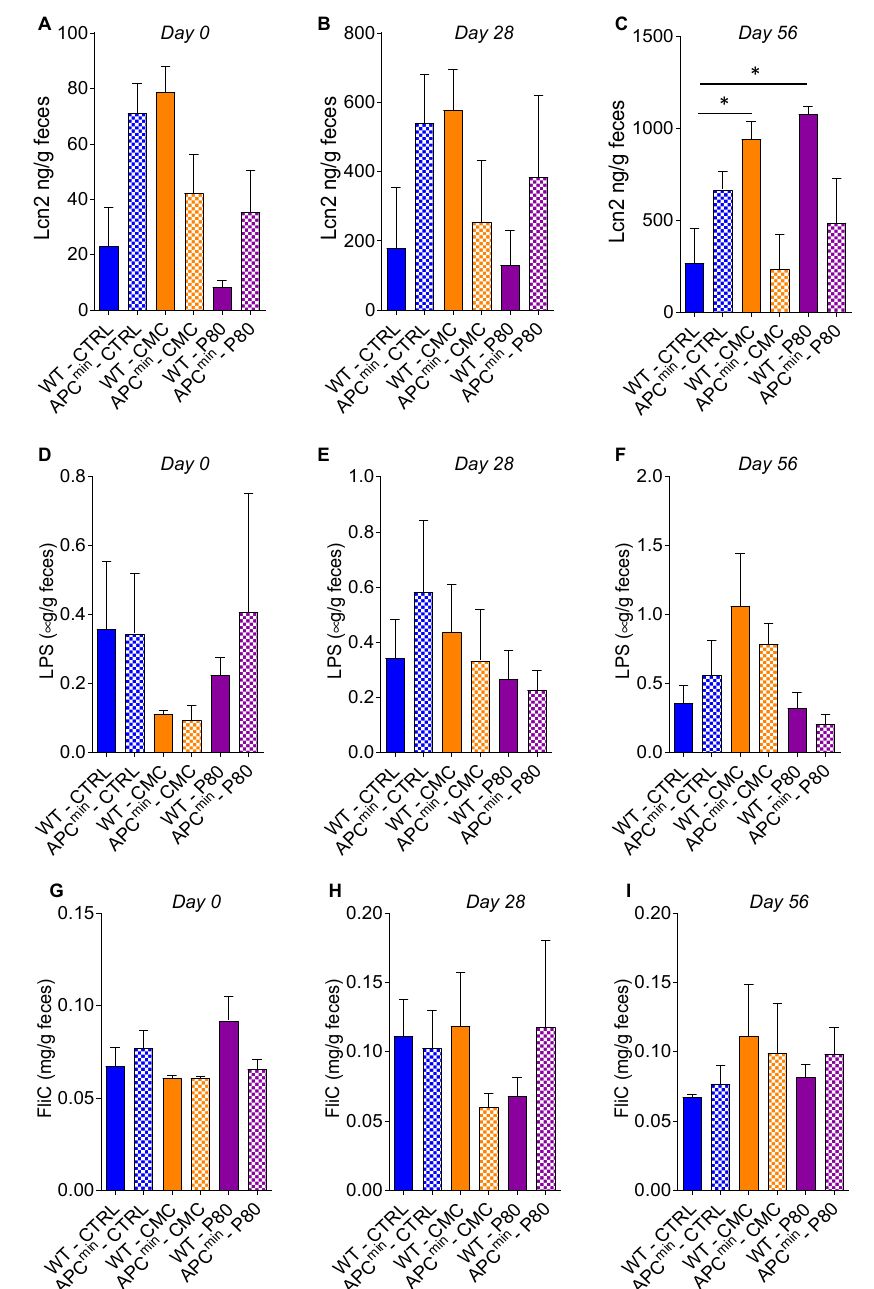
Figure 5. Dietary emulsifier consumption alters the intestinal inflammatory environment in WT and APC min male mice. Seven-week-old WT and APC min male mice were exposed to drinking water containing CMC or P80 (1.0%) for 15 weeks. ( A – C ) Fecal Lcn2 concentration and ( D – F ) bioactive levels of fecal LPS and FliC ( G – I ) were assessed at day 0 ( A , D , G ), day 28 ( B , E , H ), and day 56 ( C , F , I ). Data are the means +/ − S.E.M. ( n = 4 for the WT–CTRL group, 4 for the APC min –CTRL group, 3 for the WT–CMC group, 3 for the APC min –CMC group, 3 for the WT–P80 group and 5 for the APC min –P80 group). Significance was determined using one-way group ANOVA with a Bonferroni test (* indicates statistical significance).